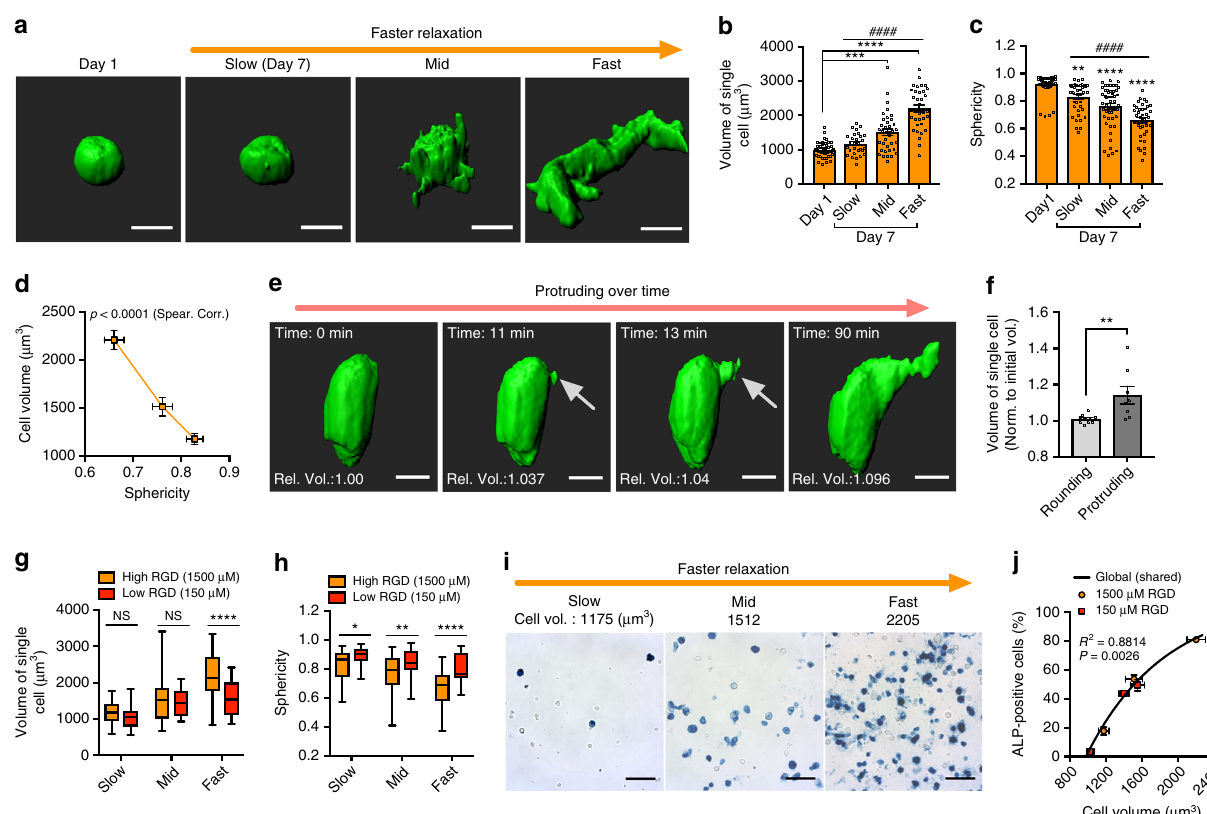
Fig. 1 Stress relaxation regulates MSC volume expansion cell and osteogenesis. a Representative 3D renderings of single MSCs from confocal imaging of a cell membrane dye at the indicated levels of stress relaxation. MSCs were cultured in hydrogels with an initial modulus of ~20 kPa and different rates of stress relaxation for 7 days. Scale bar is 10 µ m. b , c Quanti fi cation of cell volumes or sphericity of MSCs cultured in indicated conditions. ( n ≥ 30 single cells from three biological replications per each condition, #### p <0.0001 by Spearman ’ s rank correlation, **** p <0.0001, *** p <0.001, and ** p <0.01 compared with cells cultured for 1 day by one-way ANOVA test in b , c ). d Scatter plot of cell volume versus sphericity of cells cultured in hydrogels with varying stress relaxation for 7 days. e 3D renderings of a single cell extending a protrusion in a fast-relaxing hydrogel. Arrow indicates protrusion on cell. Scale bar is 10 µ m. f Quanti fi cation of altered volume of protruding or control cells during constant observation time (t < 2 h, n = 10 single cells, ** p <0.001 by Student ’ s t test). g , h Quanti fi cation of cell volume ( g ) and sphericity ( h ) of MSCs cultured in hydrogels with different rate of stress relaxation for 7 days with a RGD density of 150 µ M and 1500 µ M (* p <0.05, ** p <0.001, and **** p <0.0001 by two-way ANOVA). The box plots show 25/50/75th percentiles and whiskers show minimum/maximum. i Representative images of alkaline phosphatase staining (blue), indicating early osteogenic differentiation, for MSC cultured in gels of indicated stress relaxation for 7 days. Scale bar, 25 µ m. j Scatter plot of cell volume with the percentage of cells positively stained for alkaline phosphatase produced by MSCs cultured in hydrogels with varying stress relaxation for 7 days with a RGD density of 150 µ M and 1500 µ M. All data show as mean ± s.e.m. MSC mesenchymal stem cell, 3D